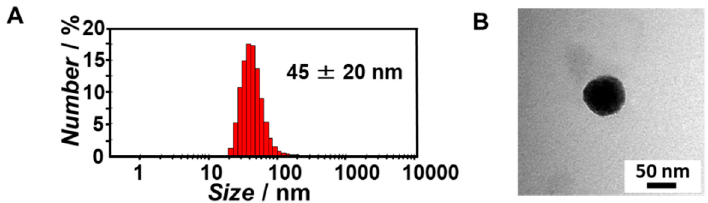
Figure 3. ( A ) Size-distributions obtained from DLS and ( B ) TEM images for co-assembly peptides (dT 20 -SS- β -annulus: β -annulus = 1:9) in water at 25 °C.